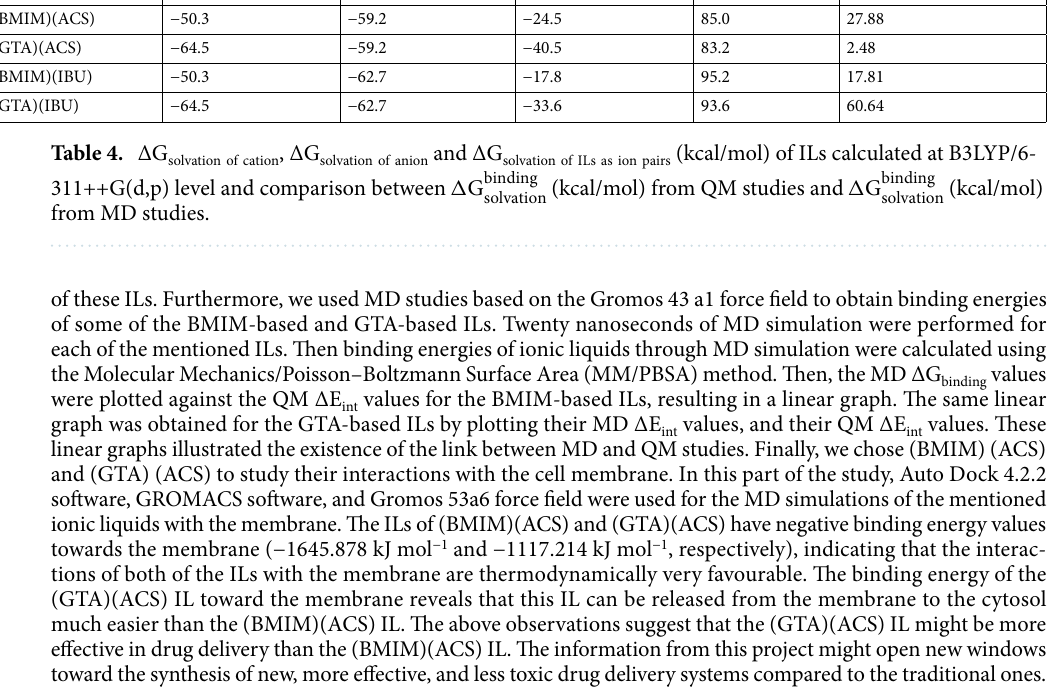
binding solvation (kcal/mol) from QM studies and